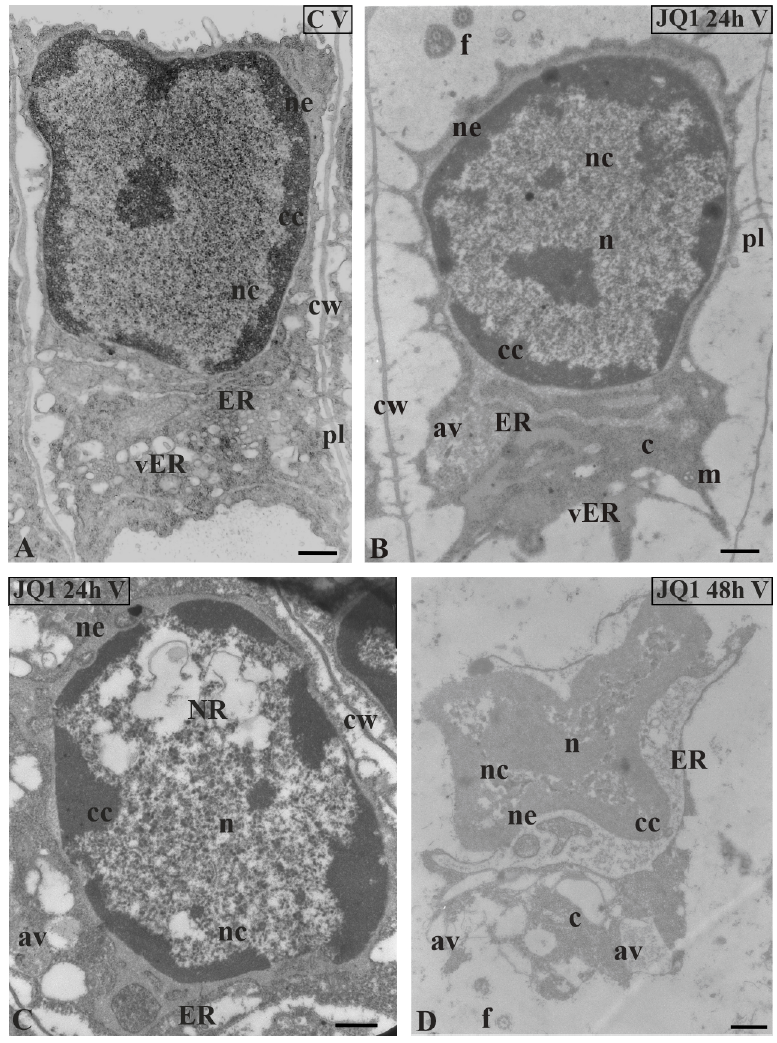
Figure 6. Ultrastructural changes in C. vulgaris spermatids at stage V; ( A ) the control; ( B , C ) after 24 h and ( D ) 48 h treatment with JQ1; ( B ) Minor changes in non-condensed chromatin, however, strongly dilated ER cisternae and nuclear envelope are visible; ( C , D ) progressive changes in the nucleus, and the presence of NR and numerous bright spaces; in cytoplasm, the presence of swollen ER cisternae, many vesicles and autolytic vacuoles. Longitudinal section of spermatids; av, autolytic vacuole; c, cytoplasm; cc, condensed chromatin; cw, cell wall; ER, endoplasmic reticulum; f, flagellum; m, mitochondrion; n, nucleus; nc, non-condensed chromatin; ne, nuclear envelope; NR, nuclear reticulum; pl, plasmodesmata; vER, endoplasmic reticulum vesicle; on individual images in the frame treatment, time of treatment and stage of spermiogenesis were given; Scale bar = 500